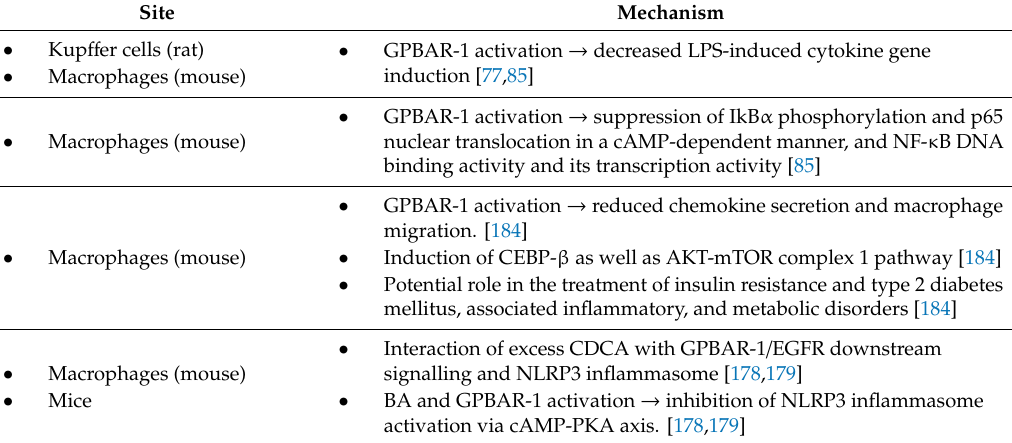
Table 4. Putative mechanisms linking G protein-coupled bile acid receptor 1 (GPBAR-1) activation with anti-inflammatory e ff